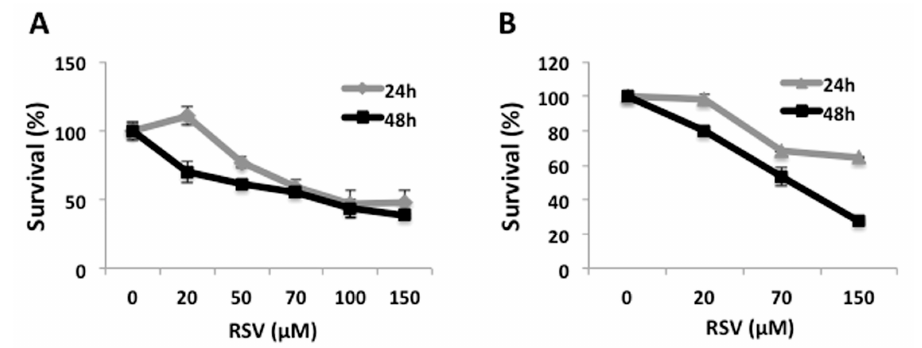
Figure 1. Effect of Resveratrol on cell viability in Ramos cells. Ramos cells were treated with resveratrol (RSV) at the indicated concentrations. ( A ) Cell viability was evaluated by MTT assay during 24 h and 48 h of treatment with resveratrol; ( B ) Cell viability was evaluated with the Trypan Blue exclusion assay during 24 h and 48 h of treatment with resveratrol. Data are presented as mean ± SD, for three independent experiments. * p < 0.05, ** p < 0.01, compared to control cells.